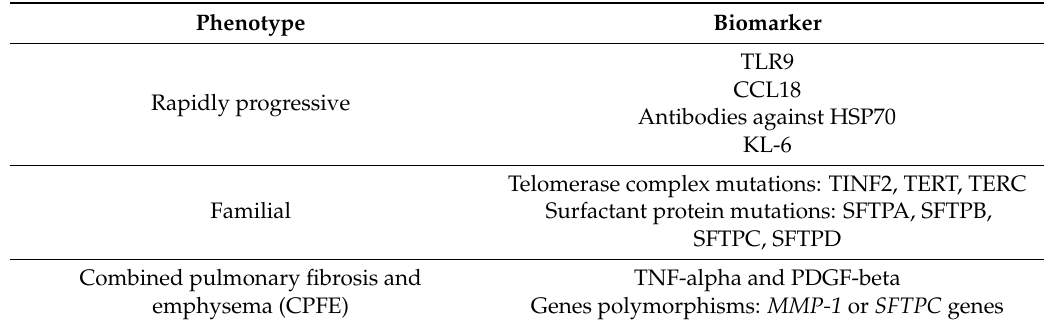
Table 1. Biomarkers (proteins and genes) associated with specific